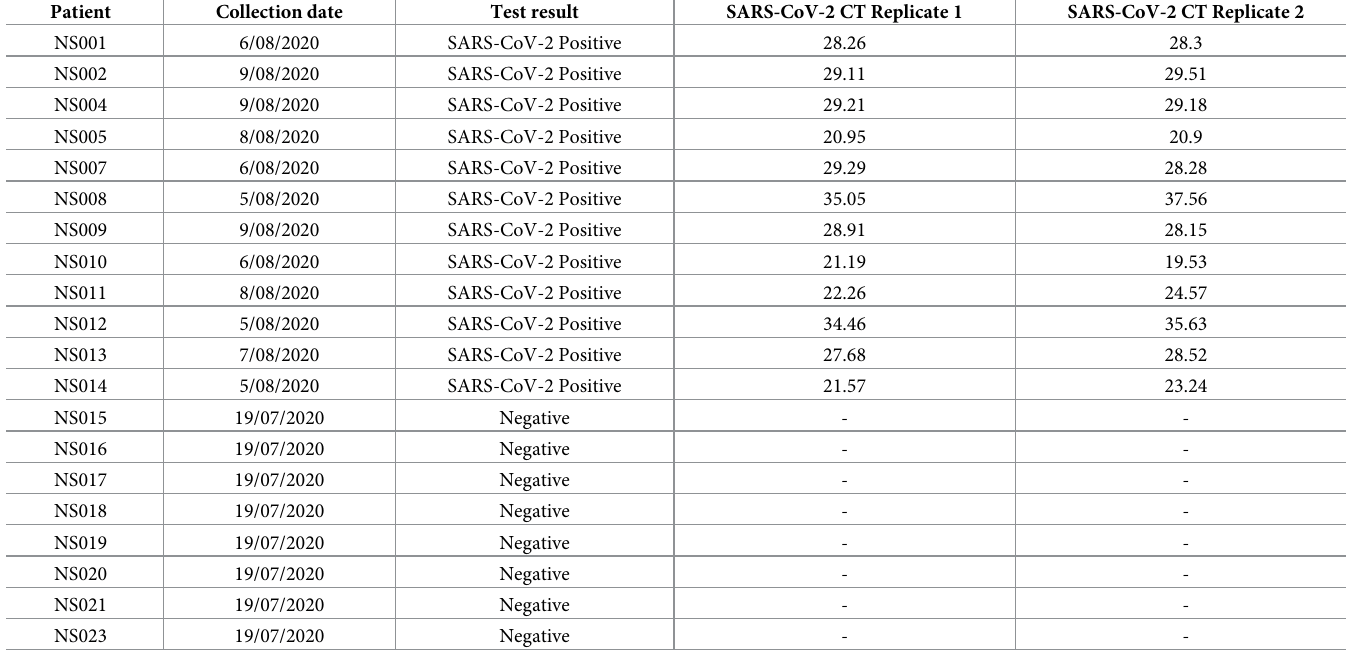
Table 1. Overview of patient